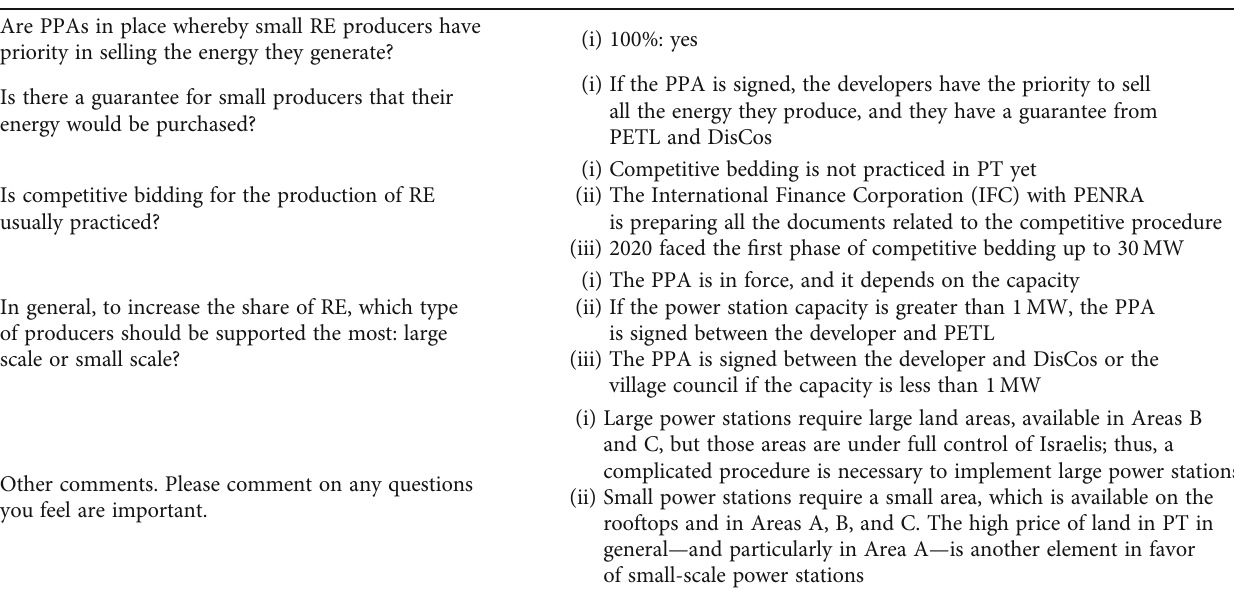
Table 5: Summarization of answers of public institutions to questions related to the market for electricity